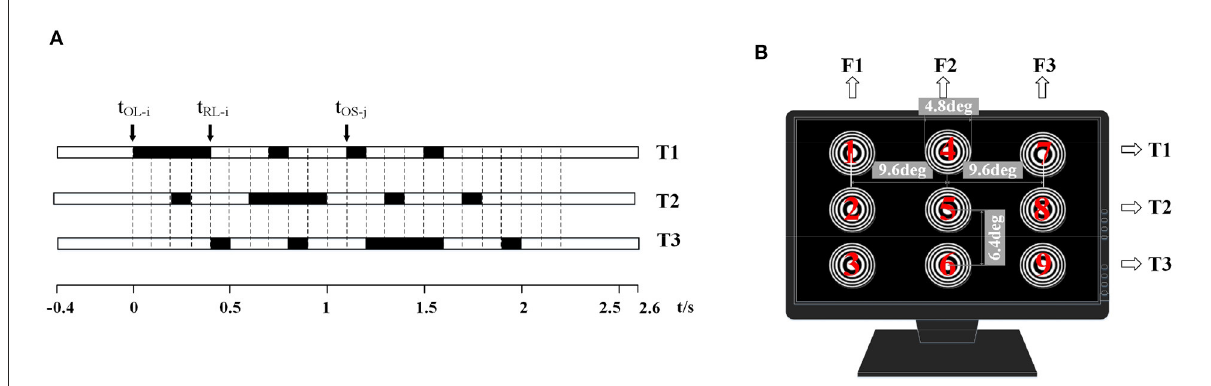
FIGURE2 The schematic diagram of the experimental stimulators. (A) A kind of arrangement for omitting events was adopted in this study with one long omission (0.4s) and three short omissions (0.1s). O L − i represents the onset time of i -th long omission, while the O Sj represents the onset time of j -th short omission. The R Li (R Sj ) represents the end time of the i(j)-th long (short) omission, or the time of reappearance of the SSVEP stimuli after the i(j)-th omission. (B) Distribution of nine stimulators on the screen. The stimulators were marked 1-9 from left to right and from top to bottom. The stimulators in the same column oscillated with the same frequency, in which F1 was 5Hz, F2 was 17Hz, and F3 was 19Hz. Three arrangements of omitting events differ in rows. T1 for the first row, T2 for the second row, and T3 for the third